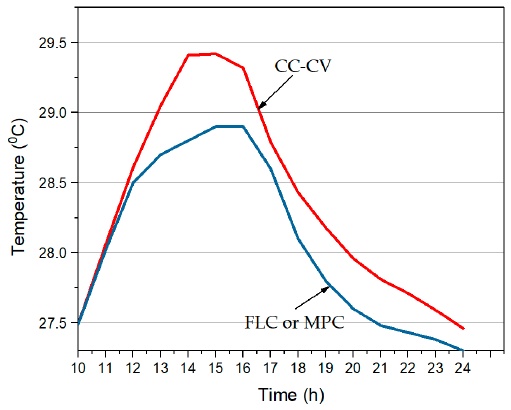
Figure 5. Simulation of battery temperature.